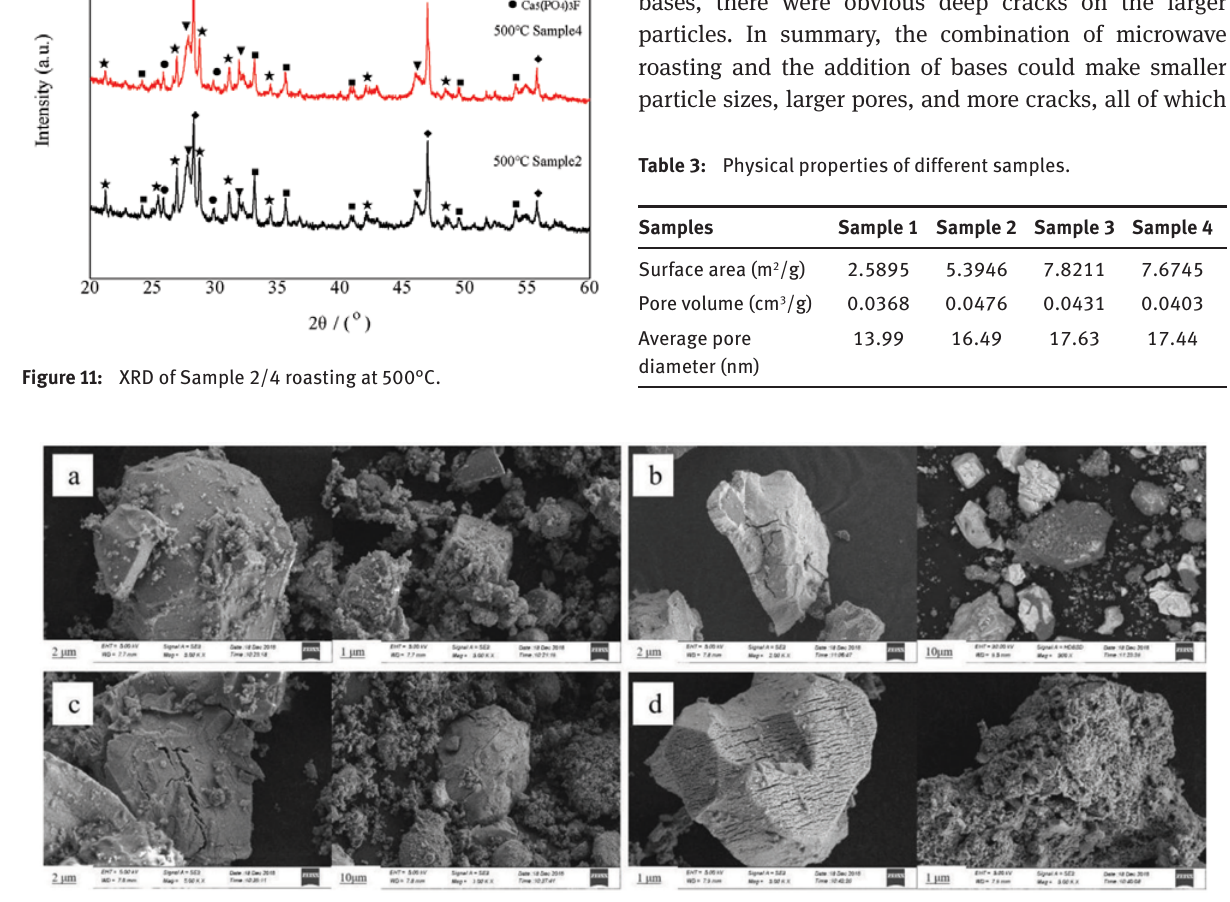
Figure 12: SEM diagram of different samples: (a) Sample 1, (b) Sample 2, (c) Sample 3, and (d) Sample